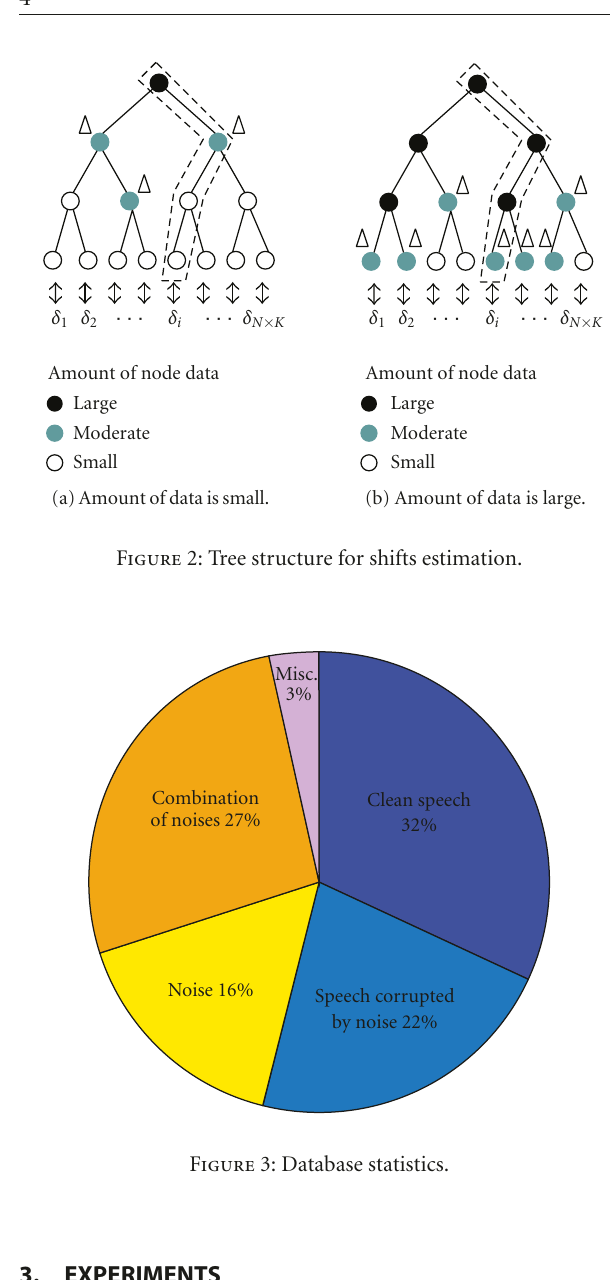
Figure 3. Each sample in the categories of clean speech and speech corrupted by noise was transcribed manually.